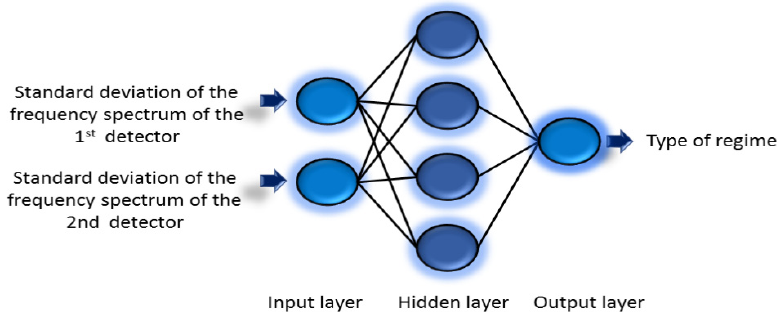
Figure 10. A neural network structure for identifying the flow regimes.